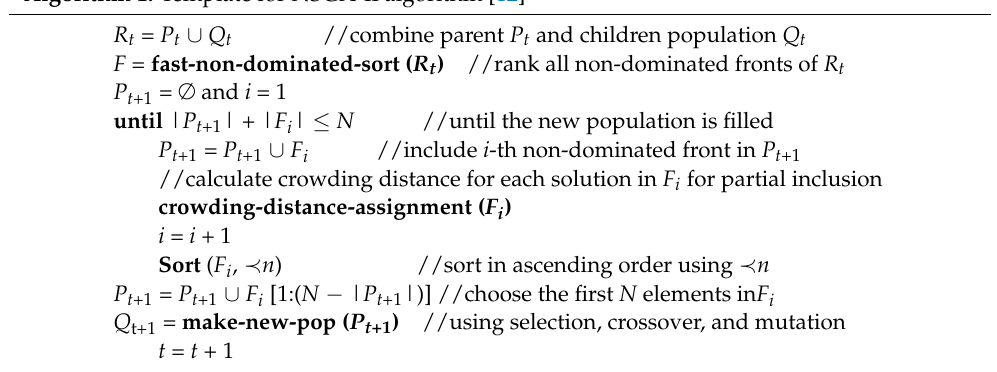
Algorithm 1. Template for NSGA-II algorithm